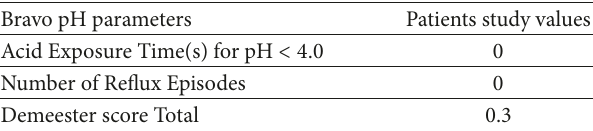
Table 1: Bravo pH parameters and patients study values.